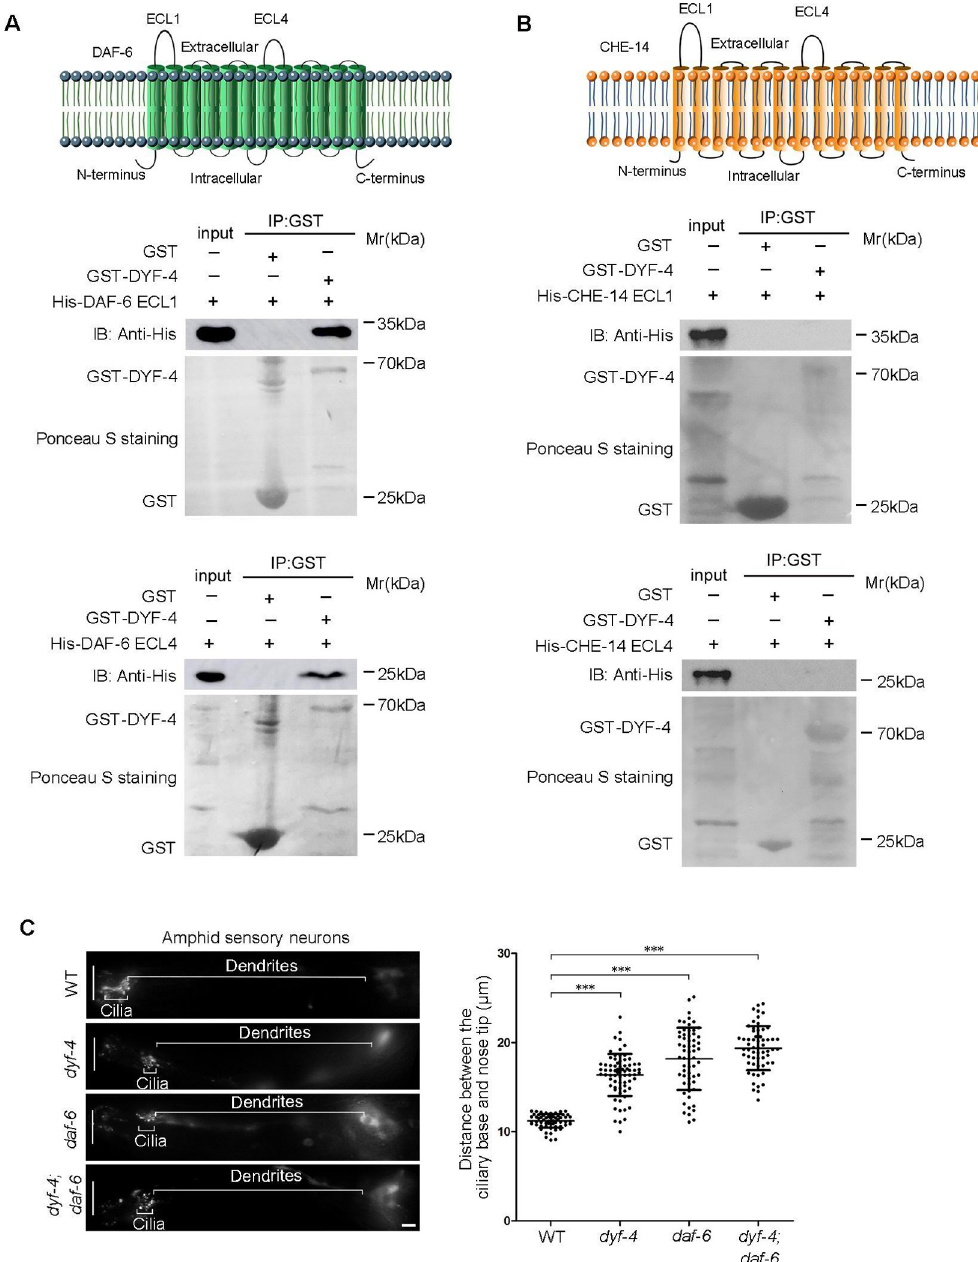
Fig 5. DYF-4 interacts with DAF-6 and acts in a same pathway. (A) DYF-4 interacted with DAF-6. Upper panel: Schematic representation of DAF-6 transmembrane protein. Lower panel: DYF-4 interacted with both DAF-6 ECL1 and DAF-6 ECL4 in the GST pull-down assay. (B) DYF-4 did not interact with ECLs of CHE-14 in the GST pull-down assay. (C) dyf-4; daf-6 double mutants showed similar phenotypes with dyf-4 or daf-6 single mutants. The white vertical line at left represents the nose tip position. Statistics of the distance between basal bodies and the nose tip were showed on the right. All data are presented as the mean ± SEM (n � 63 for each genotype). ��� P < 0.001 (Mann-Whitney test). mutants of certain combinations of TZ genes. DEX-1 and DYF-7 act in extracellular matrixes to anchor the dendritic tips or prevent the rupture of the connection between the sheath glia and the socket glia, deletion of either protein causes dendrite collapse [7,21]. Combined